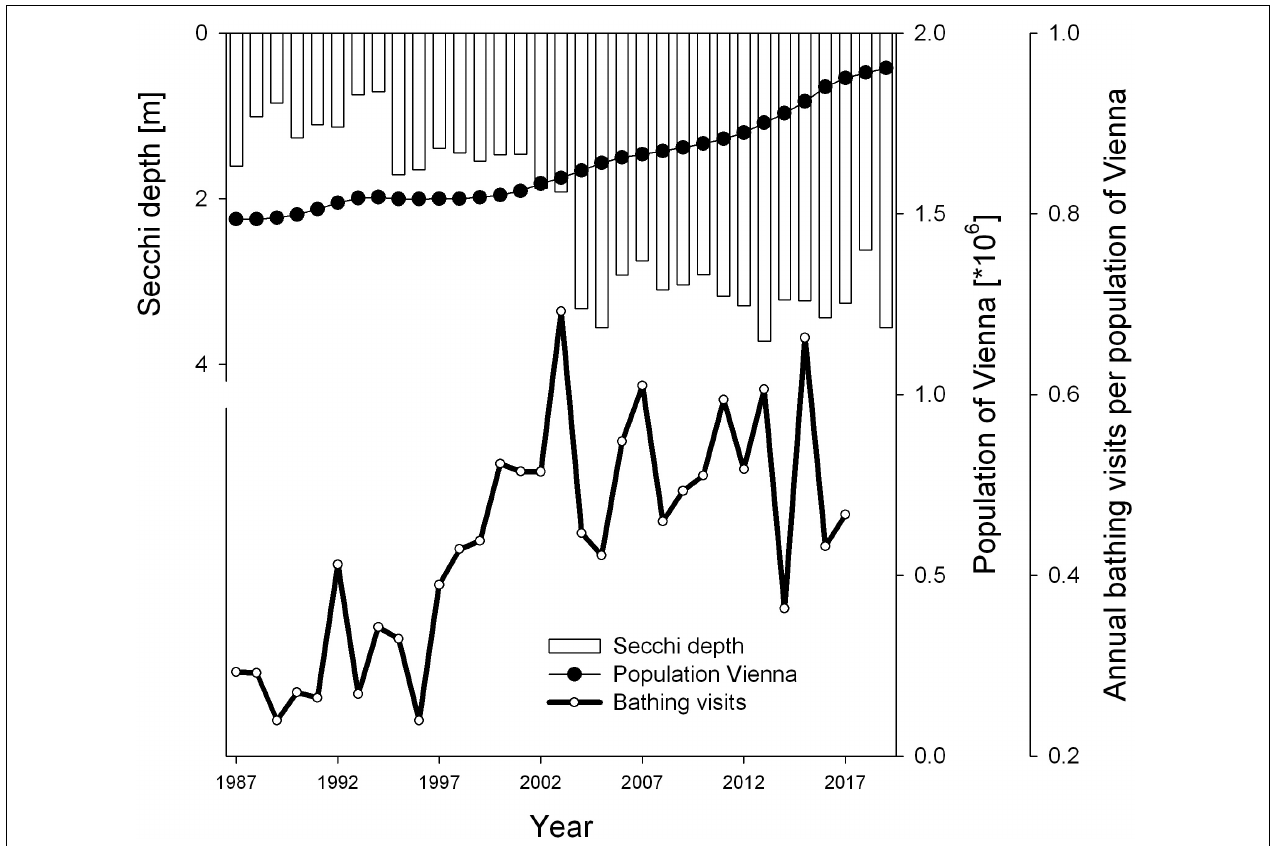
FIGURE 2 | Population development of capital city Vienna and water transparency as annual Secchi depth of Alte Donau for years 1987–2019. The number of annual bathing visits per annual population of Vienna are from 1987 to 2017 (data for population from www.statistik.at, for annual bathing visits from Hozang, 2017).